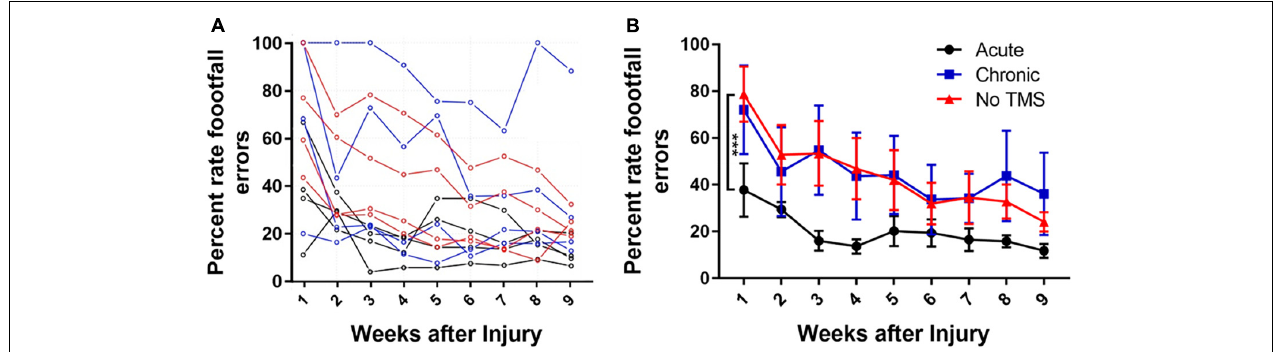
FIGURE 2 | (A) Line graph showing mean gridwalk scores measured in terms of percent footfall errors across a period of 9 weeks for each animal across all groups. The acute-TMS group had the lowest percent footfall errors compared to the chronic and no-TMS group. (B) One-way ANOVA with multiple comparison analyses show significant improvement in percentage of footfall errors measured in acute ( n = 4) vs chronic ( n = 4, p = 0.0009) and acute vs no-TMS groups ( n = 3, p = 0.0015). No significant differences were found between the chronic vs no-TMS groups across 9 weeks.